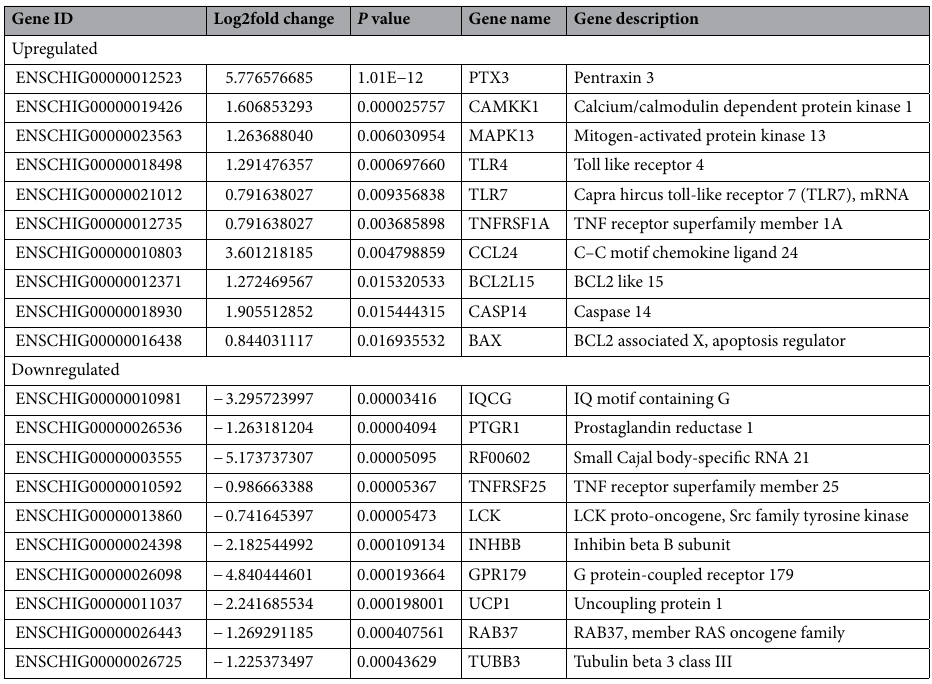
Table 4. Differentially expressed genes (DEG) in blood samples of goats transported for 180 min vs. goats not transported